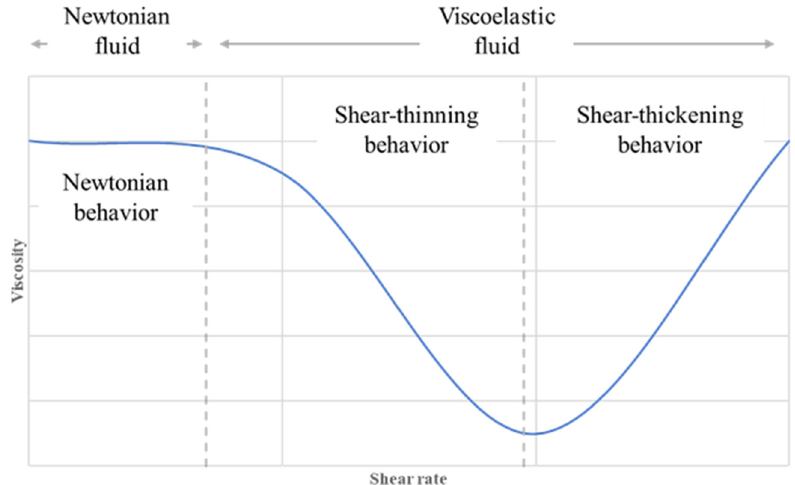
Figure A1. Schematic demonstration of both shear thinning and thickening fluid behaviour in porous media.